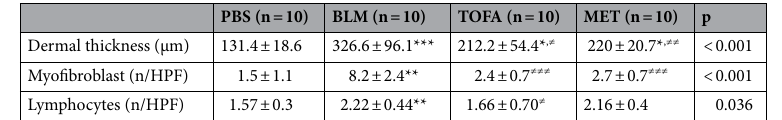
Table 1. Histopathological findings in the study groups. BLM bleomycin, MET metformin, PBS phosphate- buffered saline, TOFA tofacitinib , HPF high-power field. Data were expressed as mean ± standard deviation. When compared with the PBS group: *p < 0.05, **p < 0.01, ***p < 0.001. When compared with the BLM group: ≠ p < 0.05, ≠≠ p < 0.01, ≠≠≠ p < 0.001.